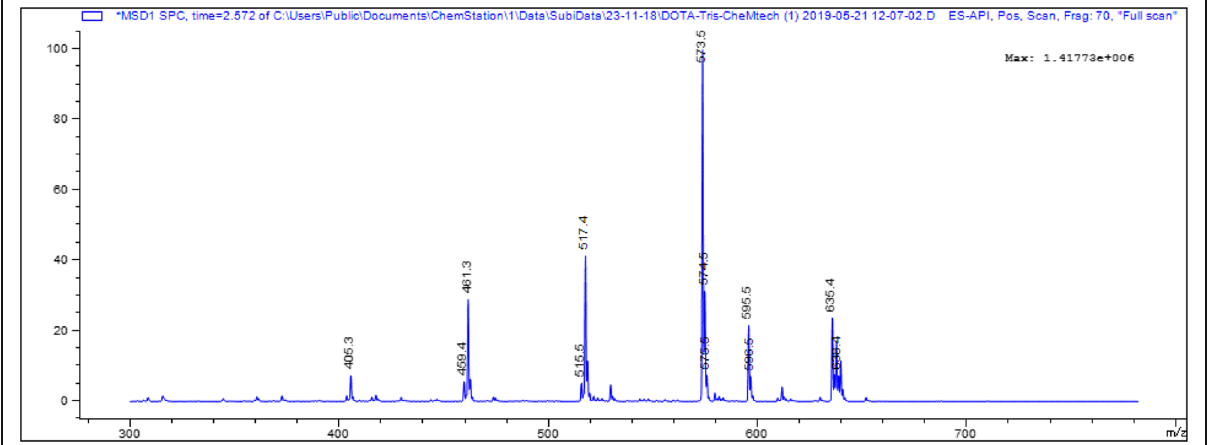
Fig. 2 Mass spectrum profile of the commercially available DOTA-tris (t-Bu ester). As can be seen, besides the main product peak at 573, DOTA (tetraxetan) peak at 405, monoalkylating product peak at 461, and dialkylating product peaks at 517 are clearly visible in the mass spectrum. In addition, the peak found at 635 possibly correlated with tetraalkylating product 629 (M + t-Bu)